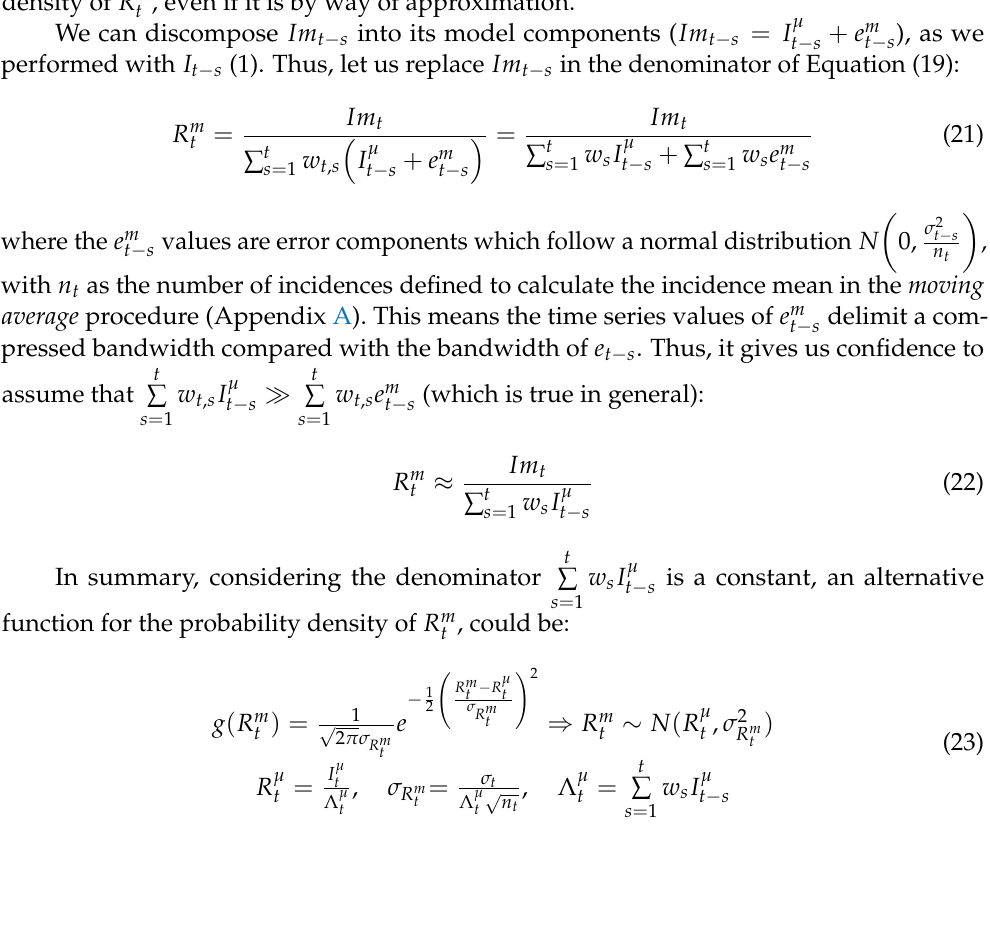
, at time t = 100, following a t